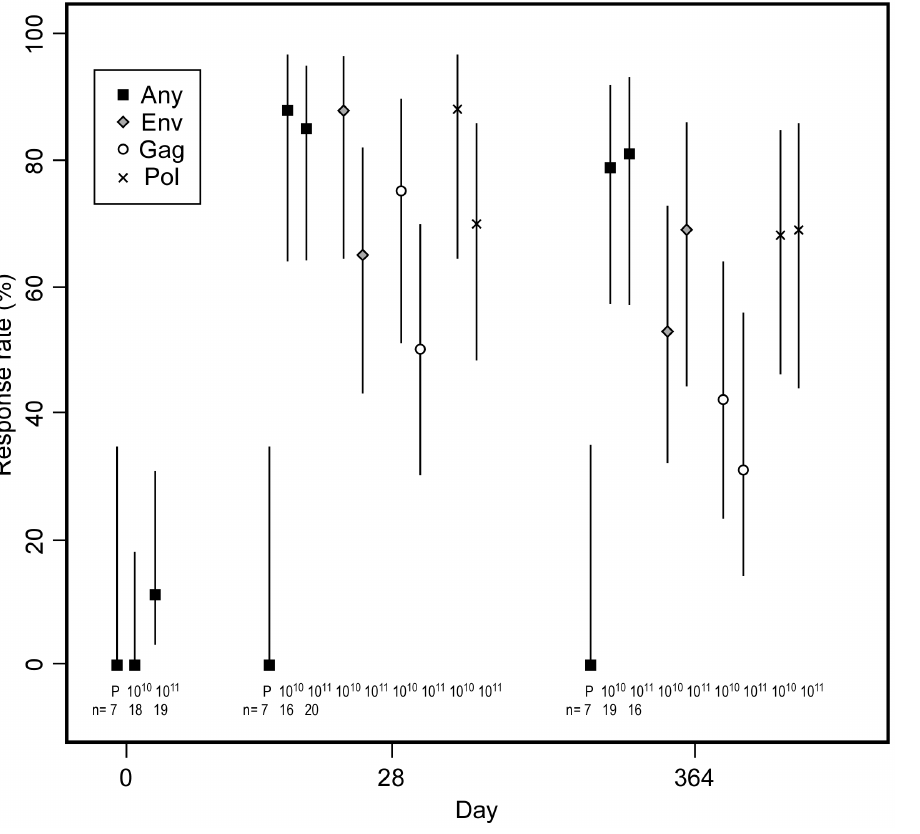
Figure 3. T-cell responses to HIV antigens by IFN- c ELISpot. Points indicate percentage of participants with positive responses; n denotes the number in each group with ELISpot data. Lines indicate 95% confidence intervals.